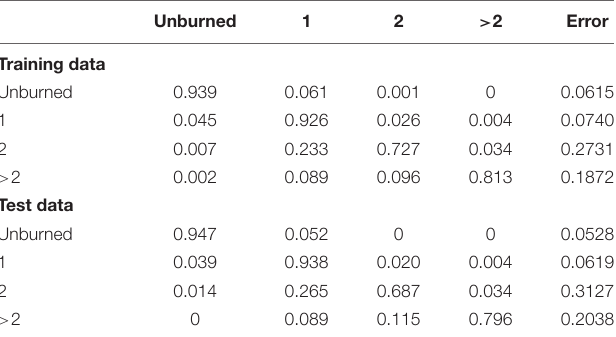
TABLE 3 | Confusion matrix of the proportional classification accuracy for four fire frequency classes (number of fires from 1972 to 2010) in the Mojave Desert of North